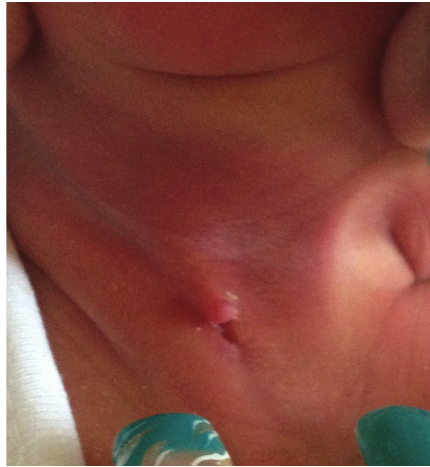
Figure 1: Linear craniocaudal pink track in the anterior neck with a skin tag arising from its superior aspect.